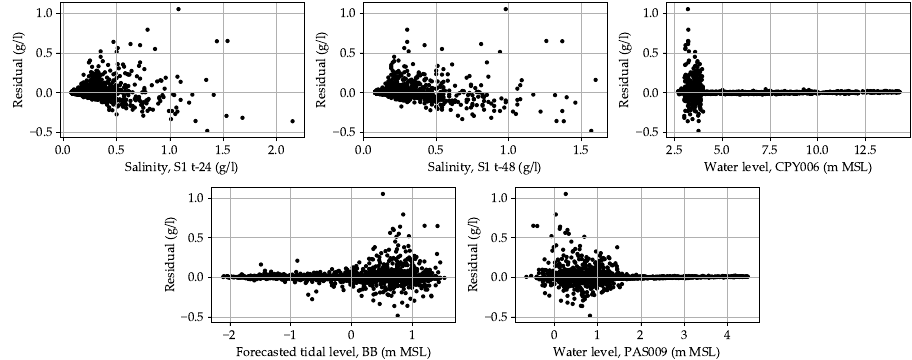
Figure A1. Residuals for the single model candidate